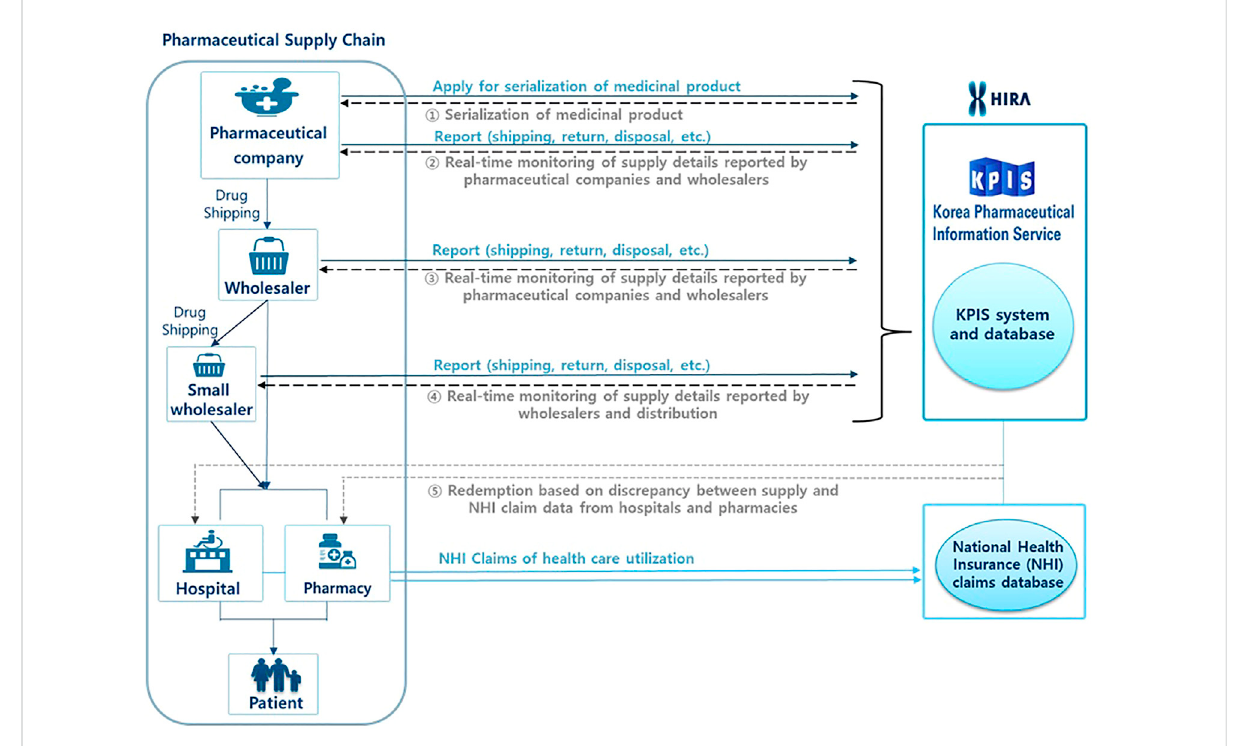
FIGURE 1 Schematic diagram of the functions of the Korean Pharmaceutical Information Service